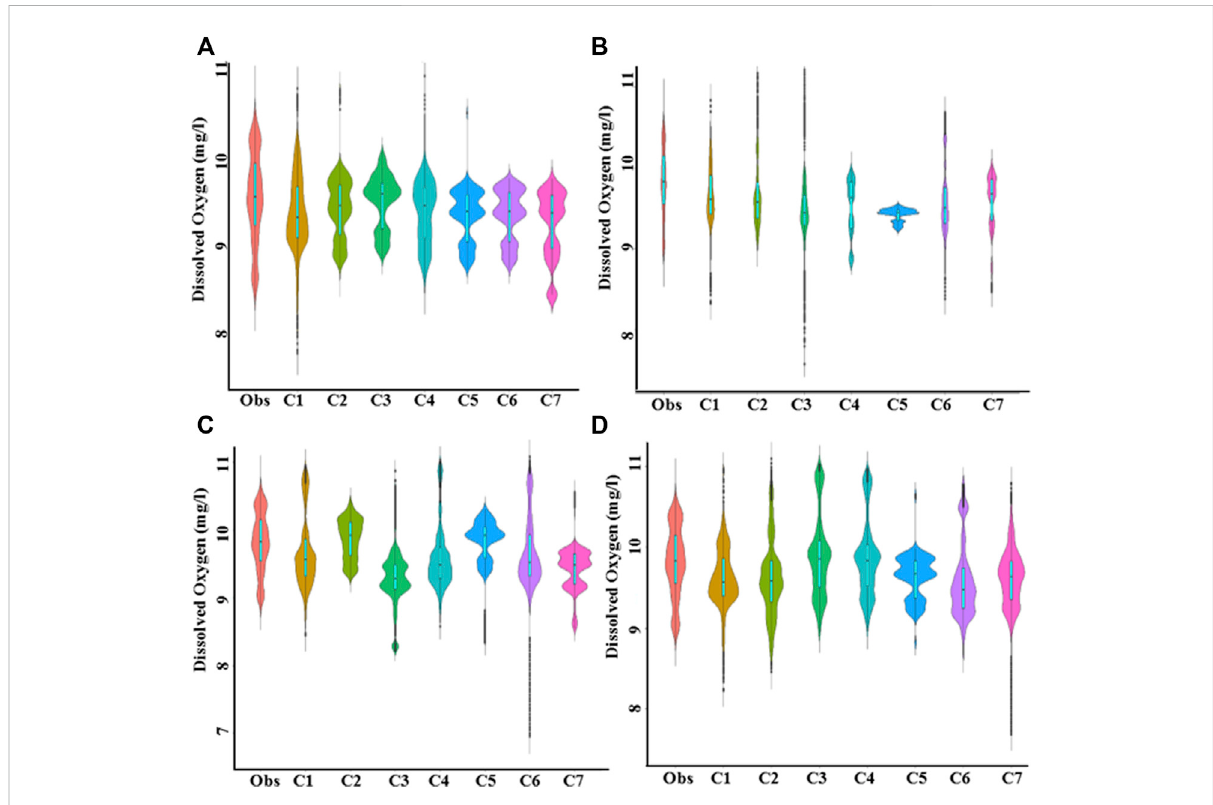
FIGURE 10 Split – violin plot showing the relative performance of (A) NF-GWO; (B) NF; (C) NF-SC; and (D) NF-FCM models in replicating the probability distribution of observed data during the testing phase at